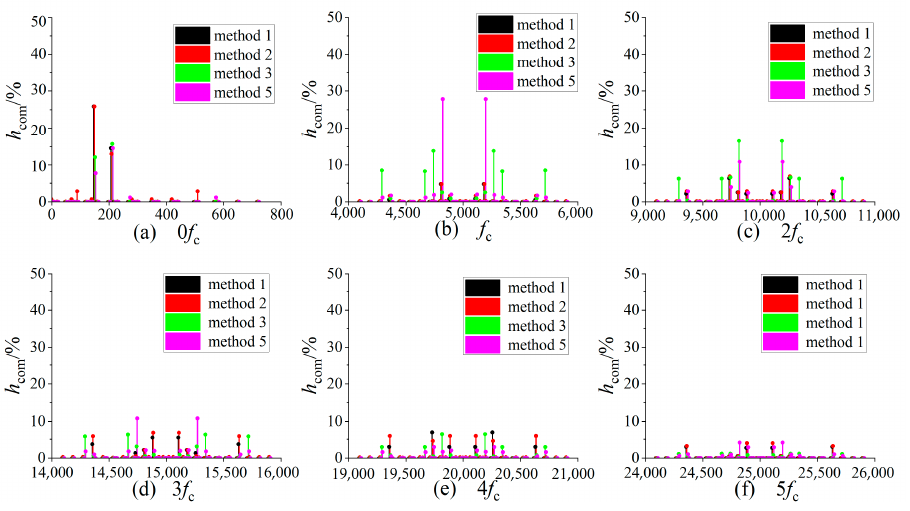
Figure 14. Partial enlargement of Figure 13. Table 4. Per-unit value of common-mode components at m = 0.7.